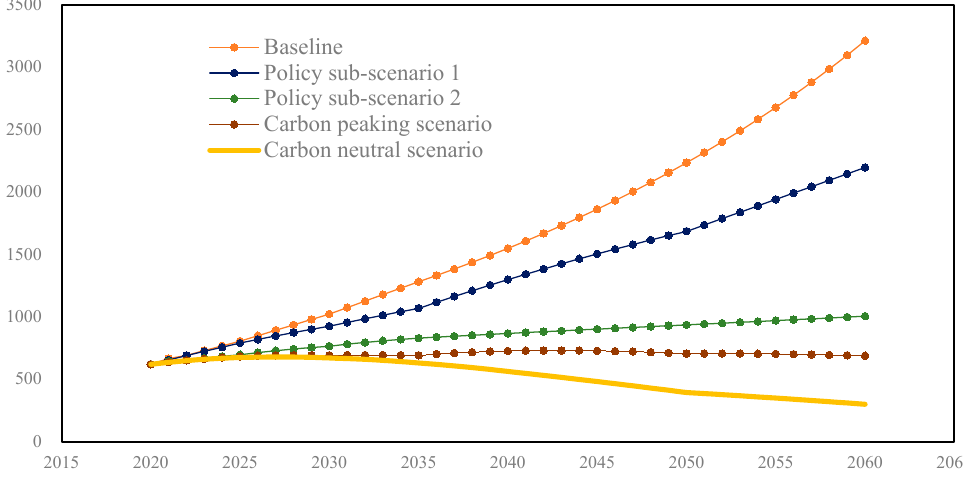
Figure 13. Comparison of petroleum products demand under di ff erent scenarios.